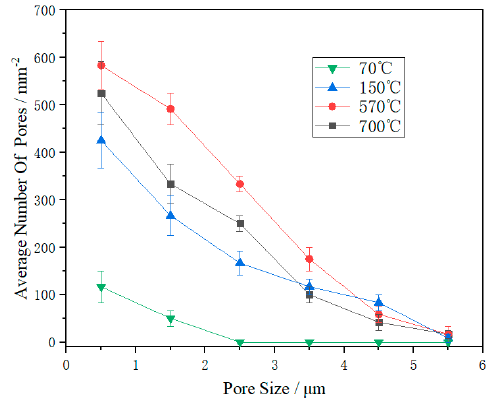
ff erent temperatures. Coatings 2020 , 10 , x FOR PEER REVIEW